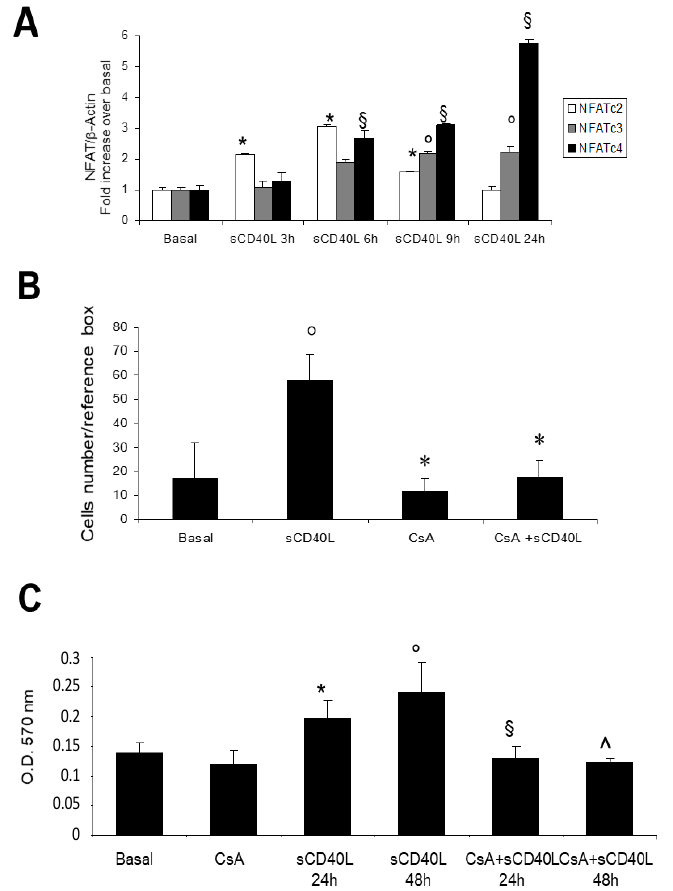
Figure 3. ( A ) CD40L-induced NFATs expression in RCC cell lines: Quiescent RCC cell lines were stimulated with sCD40L (100 ng/mL) and sCD40L enhancer (1 µ g/mL) for the indicated time periods and then lysed in Trizol. RNA expression was investigated by real time PCR. The figure is representative of three experiments. *, § , ◦ p < 0.001 vs. basal. ( B ) The effect of NFATs inhibition by cyclosporine A on sCD40L-induced RCC cell migration. The number of cells migrated into the denuded area in basal condition (sCD40L enhancer 1 µ g/mL alone), after stimulation with sCD40L (100 ng/mL) and sCD40L enhancer (1 µ g/mL) and after pre-incubation with cyclosporine A (CsA) and subsequent stimulation with sCD40L and enhancer for 24 h at 37 ◦ C, was determined by counting, as described in methods. Results were expressed as the number of cells present in the reference box (mean ± SD of three experiments on different RCC lines), normalized to the level of total migration in the basal population. ◦ p = 0.03 vs. basal; * p = 0.01 vs. sCD40L. ( C ) The effect of NFATs inhibition by cyclosporine A (CsA) on CD40L-induced cell proliferation in RCC cell lines. MTT assay was performed as described in methods. The figure is representative of three different experiments on different RCC lines. * p < 0.01 vs. basal; ◦ p < 0.07 vs. basal; § p < 0.05 vs. sCD40L 24 h; ˆ p < 0.05 vs. sCD40L 48 h. To further assess the role played by NFAT factors in RCC cell migration induced by sCD40L, we analyzed the specific effect of calcineurin/NFAT inhibitor, cyclosporin A, [21,22] on cell motility by a migration assay. Interestingly, we observed that cell